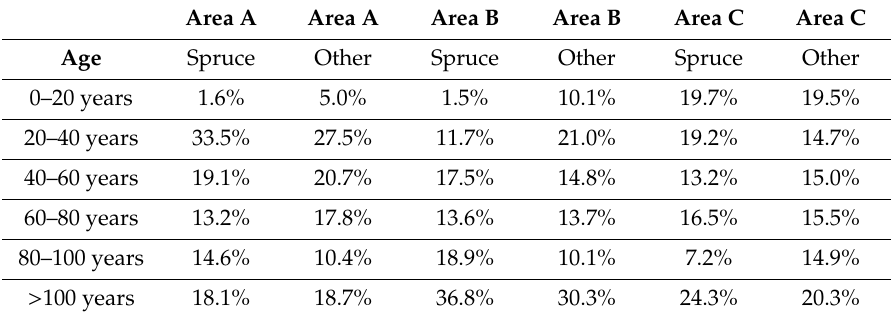
Table 2. Species composition in three areas: A—Western Sudety, B—Eastern Sudety and C—Western Beskidy [Forest Data Bank, 2019].